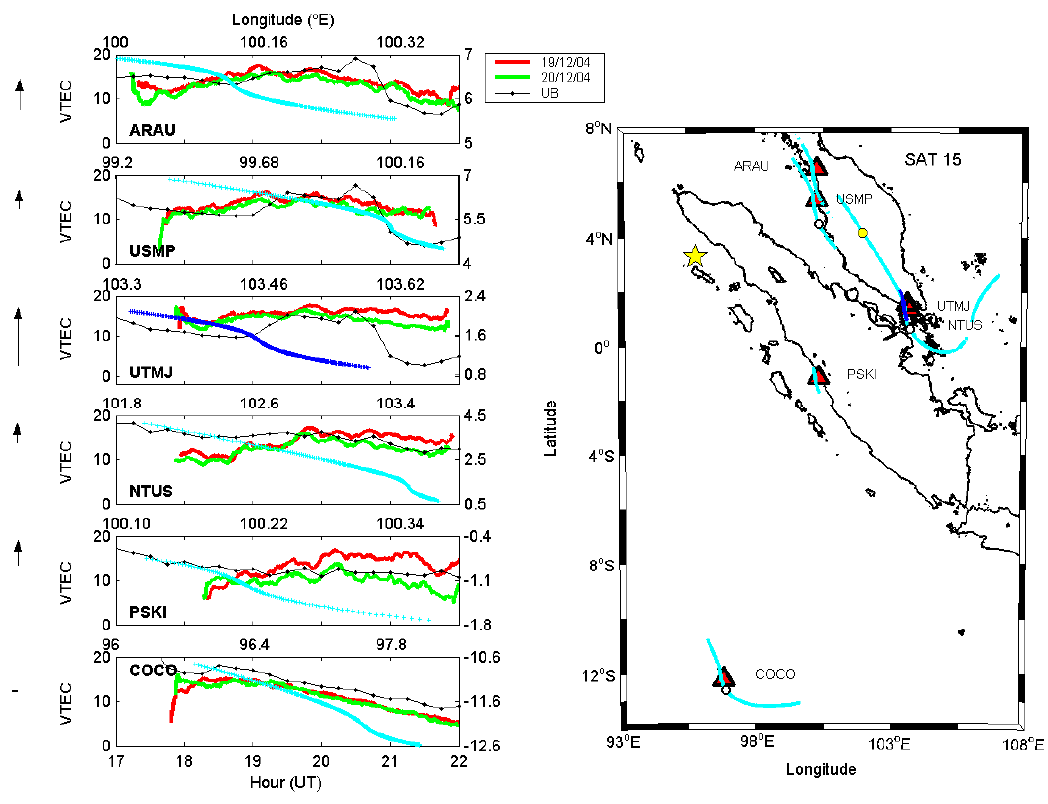
Fig. 4. Temporal and spatial TEC variations as well as the associated upper bound at 6 GPS stations for satellite 15 observed during 17-22 UT on 19 and 20 December 2004. The right panel of the figure shows the satellite trajectories on 19 December. The solid and open circles denote time marks for the start and end of the observation period, respectively.